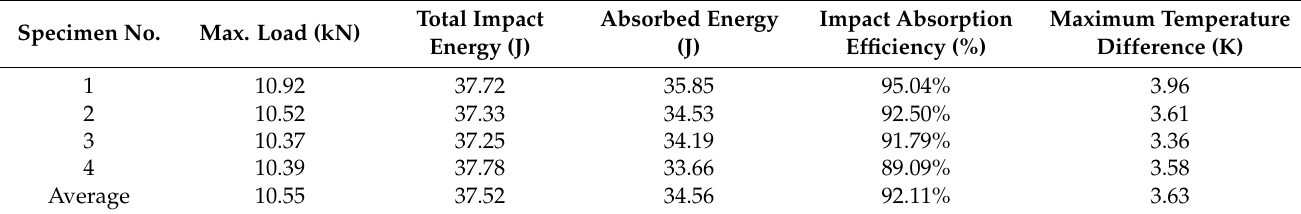
Table 3. Impact test results for specimens laminated in +45 ◦ / − 45 ◦ direction.